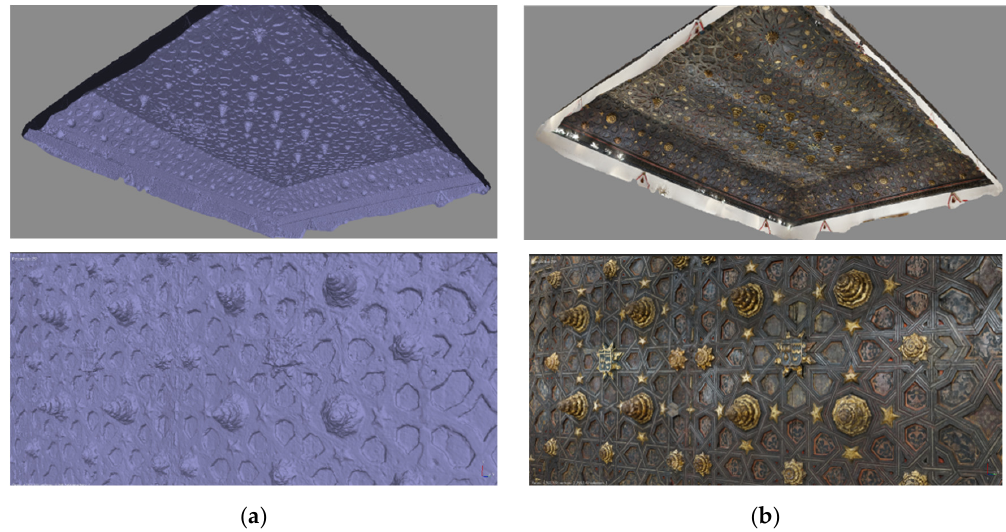
Figure 19. General view and details of the mezzanine ceiling from photogrammetry: ( a ) 3D surface model. ( b ) 3D textured model.